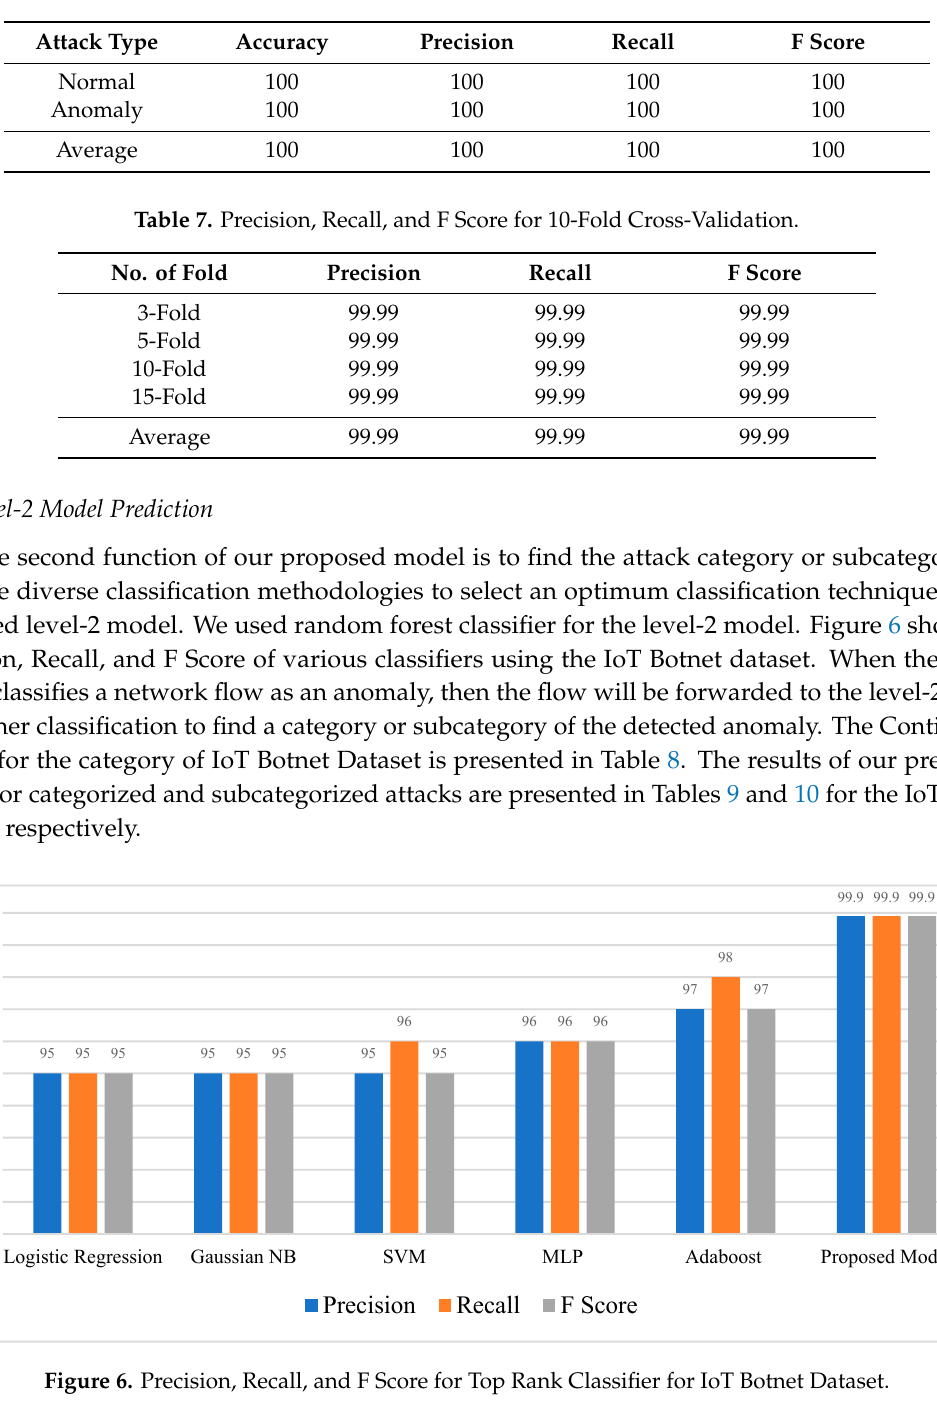
159 Table 9. Accuracy Precision, Recall, and F Score for Category. Attack Type